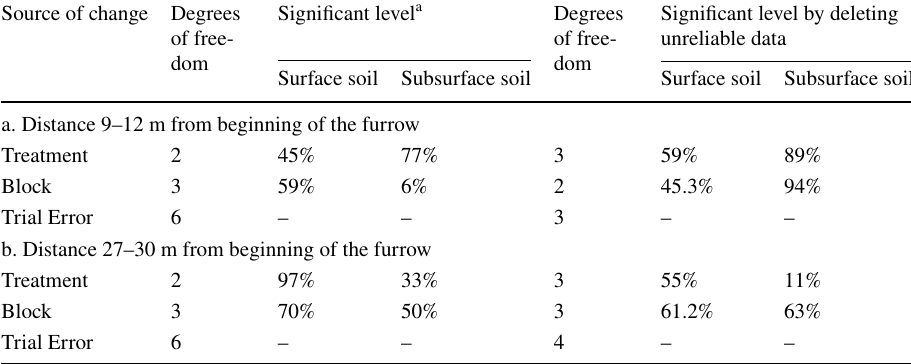
Table 5 The result of statistical analysis of random block design related to "relative changes in soil moisture holding